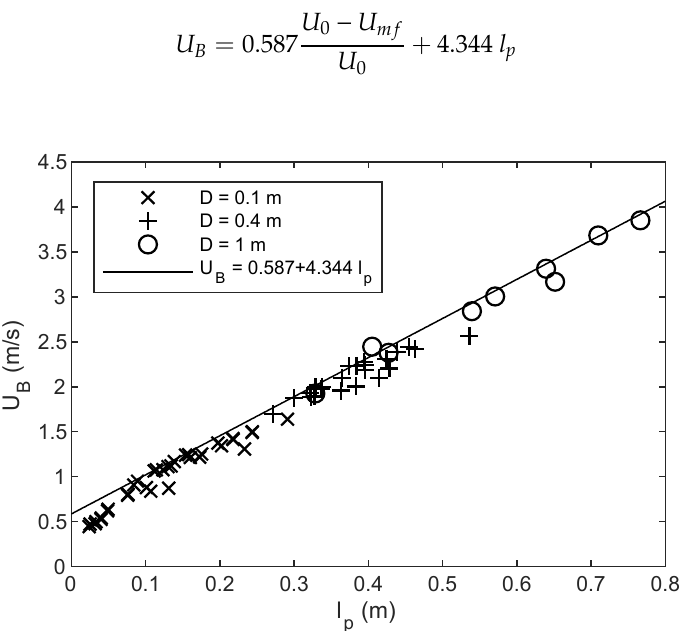
Figure 11. Bubble velocity as a function of the mean pierced length at different plant diameters, heights above the gas distributor and superficial gas velocities (cross-sectional averaged) including Equation (13) at U 0 >> U mf as a limiting case.